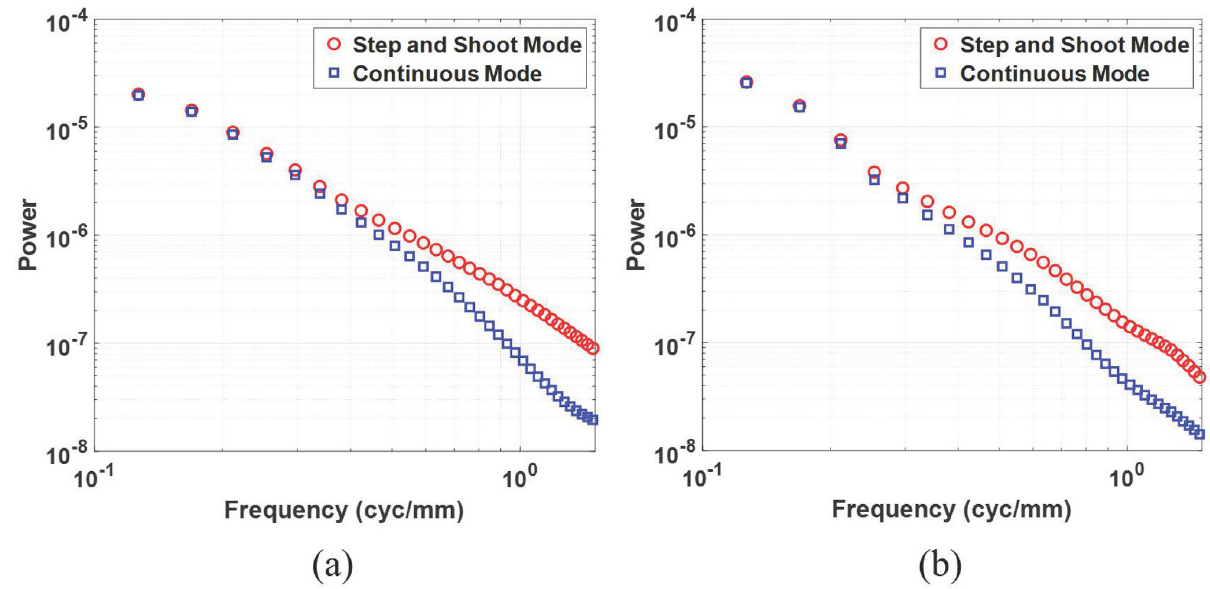
Fig 8. Anatomical noise power spectrum from the reconstructed in-plane images using (a) simulated breast phantom and (b) BR3D breast phantom.